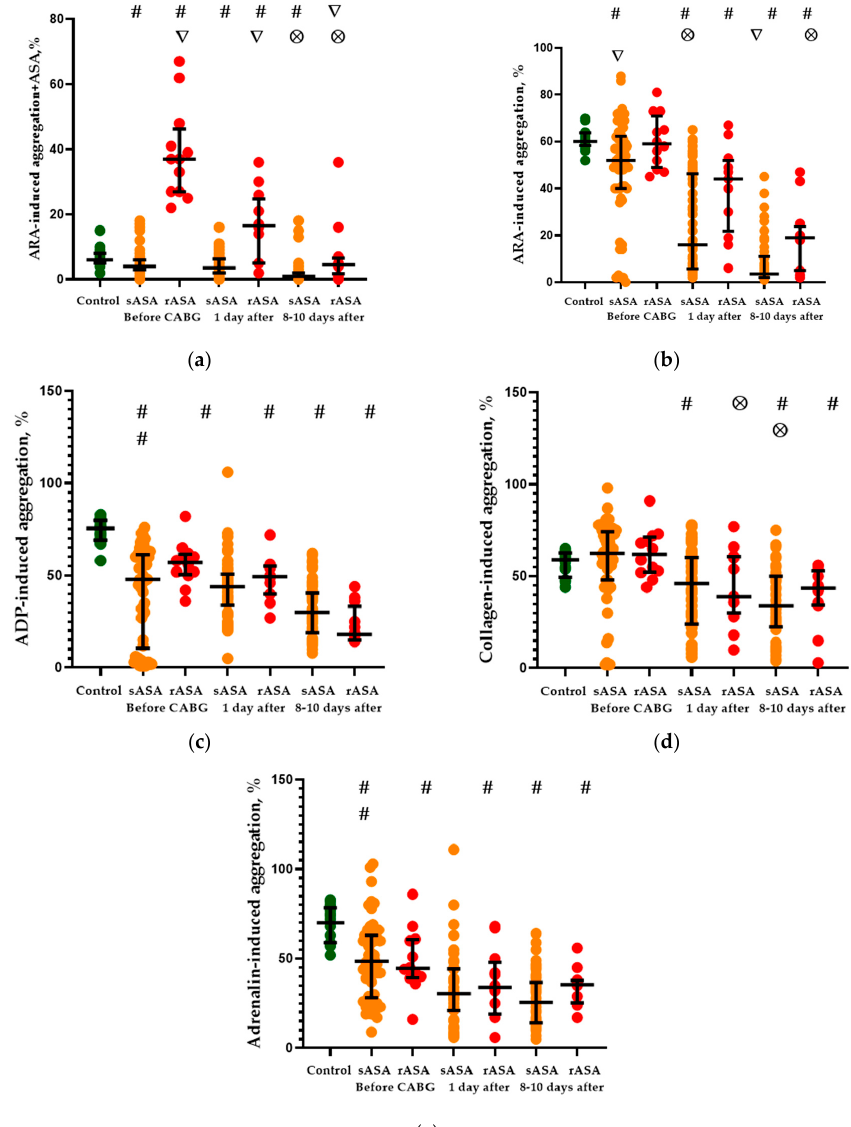
Figure 1. Induced platelet aggregation in sASA and rASA patients with CHD before and after CABG. ( a ) ARA-induced platelet aggregation with the addition of ASA. ( b ) ARA-induced platelet aggregation. ( c ) ADP-induced platelet aggregation. ( d ) Collagen-induced platelet aggregation. ( e ) Adrenalin-induced platelet aggregation. The data represent the medians and interquartile ranges (Me (C 25 —C 75 )). # : p < 0.05 vs. control (Mann-Whitney U test), ∇ : p < 0.05 between indicators of sASA and rASA patients in each period of the survey (Mann-Whitney U test), ⊗ : p < 0.05 vs. with indicators of the patients before CABG (Wilcoxon matched pairs